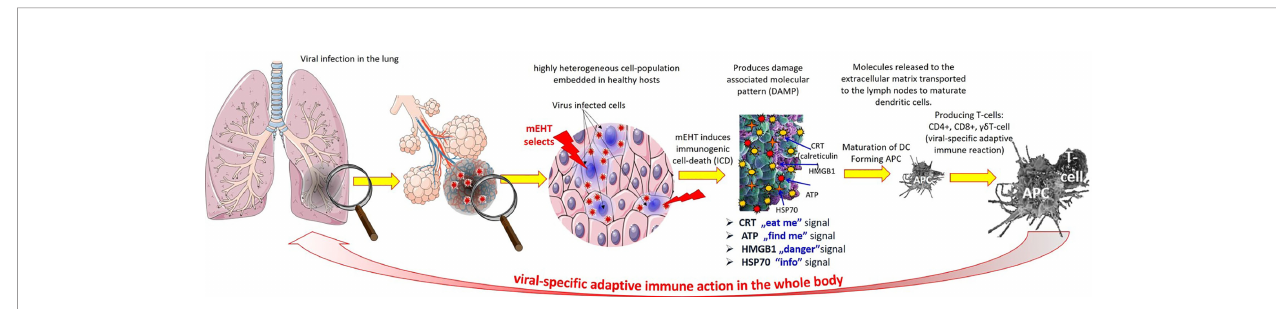
FIGURE 6 | The antiviral immune-effect of mEHT: the mEHT selects the infected cells which release a damage-associated molecular pattern through the process of immunogenic cell-death. The DAMP provides viral genetic information to maturate the dendritic cells producing antigen presentation for T-cells, which turn to viral speci fi c CD4+ CD8+ form. The viral-speci fi c T-cells attack the infected cells in all over the